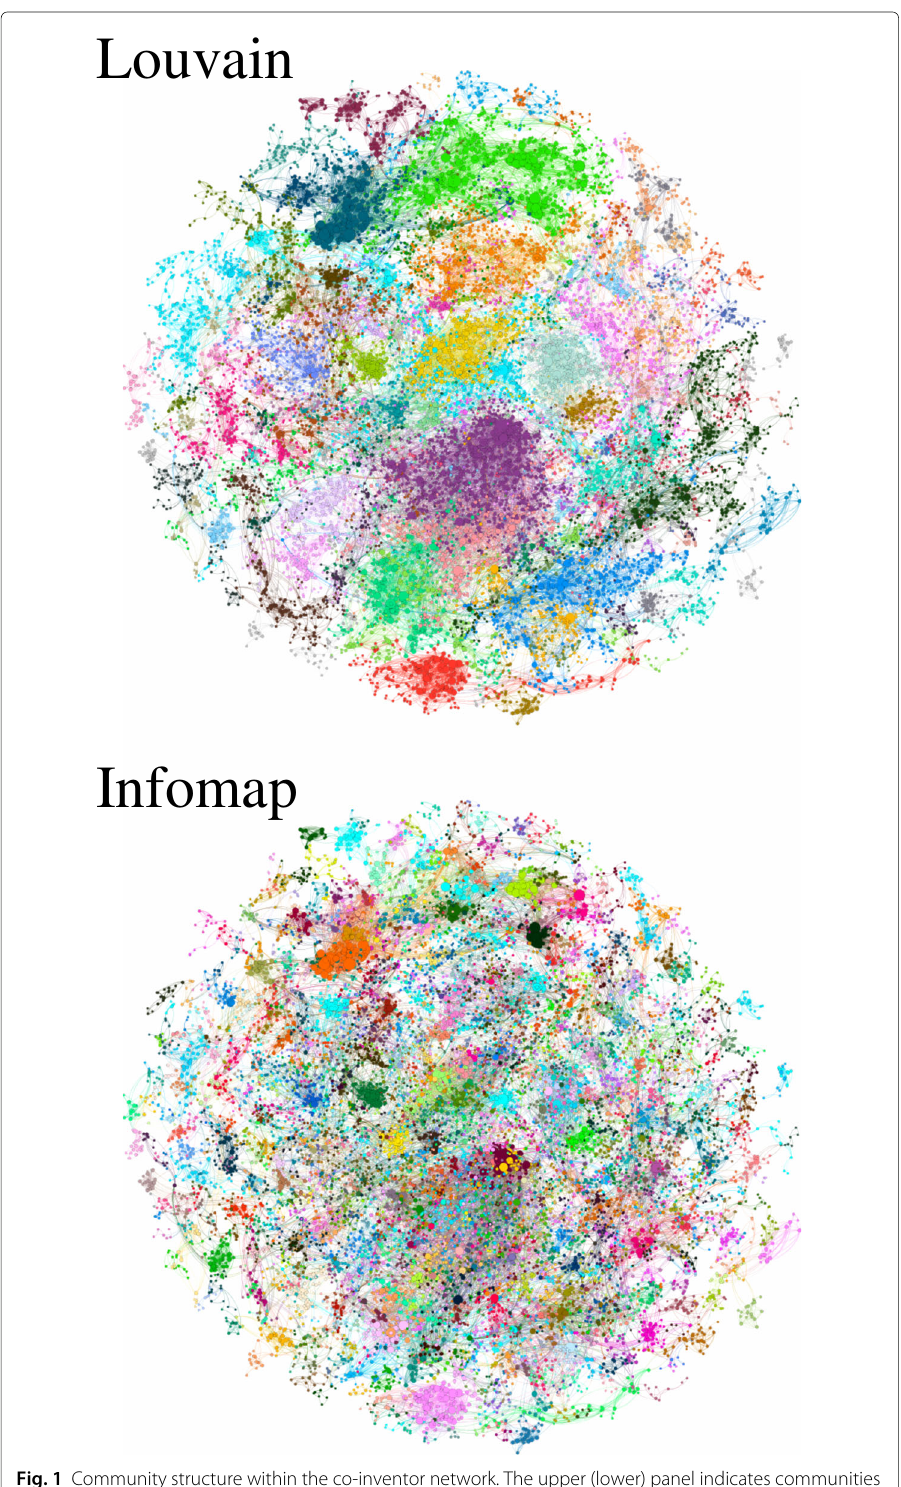
Fig. 1 Community structure within the co-inventor network. The upper (lower) panel indicates communities in the largest connected component of the co-inventor network identified by the Louvain (Infomap) algorithm using different colors (but with some colors being reused in the lower panel due to the overall large number of communities yielded by Infomap). Note how certain groups of communities identified as separate by Infomap are clustered together by Louvain. The size of the circle indicating a node is proportional to the number of edges attached to that node. Images created using Gephi (Bastian et al.